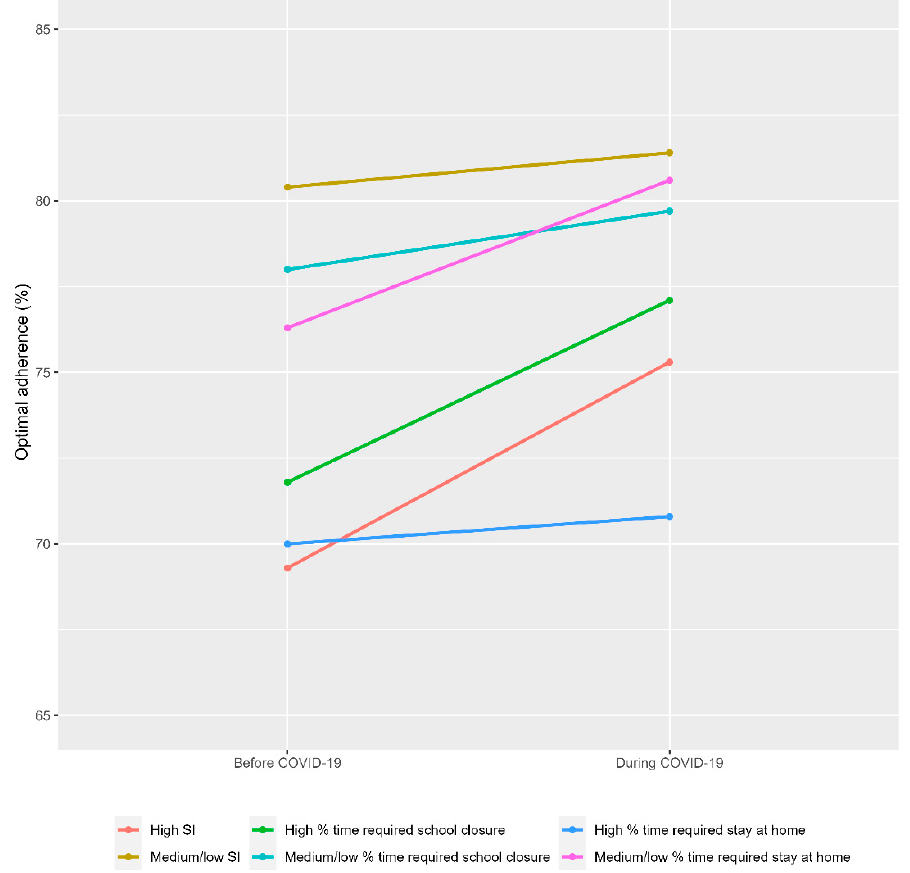
Figure 1. Change in the proportion of optimal adherence over time by countries (equally weighted) with high versus medium/low regulations.